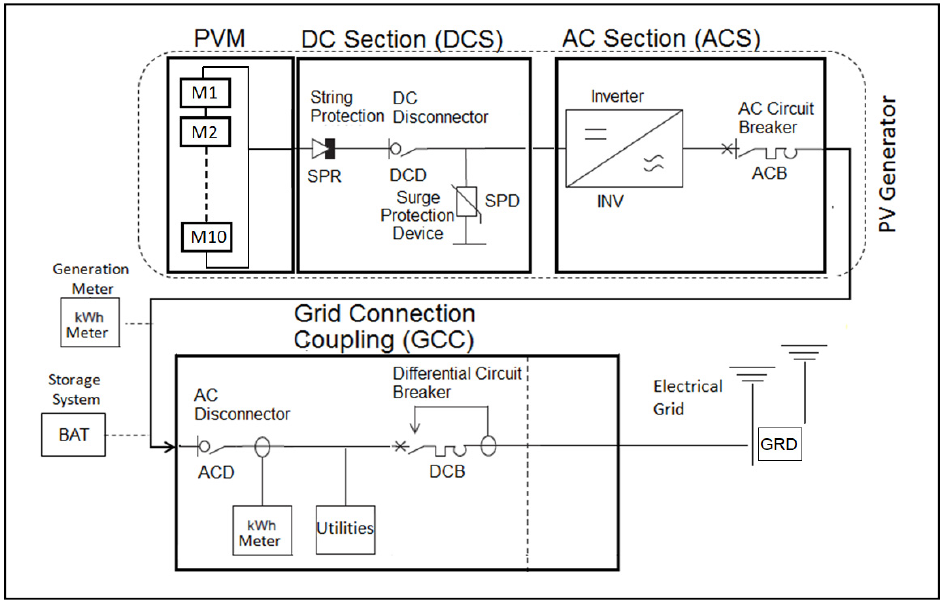
Figure 5. Schema of the deterministic process of the PV system, including the battery.